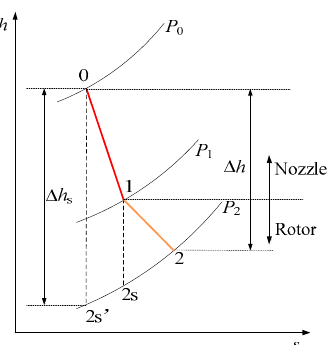
Figure 3. Working fluid flow process in the radial-inflow turbine.